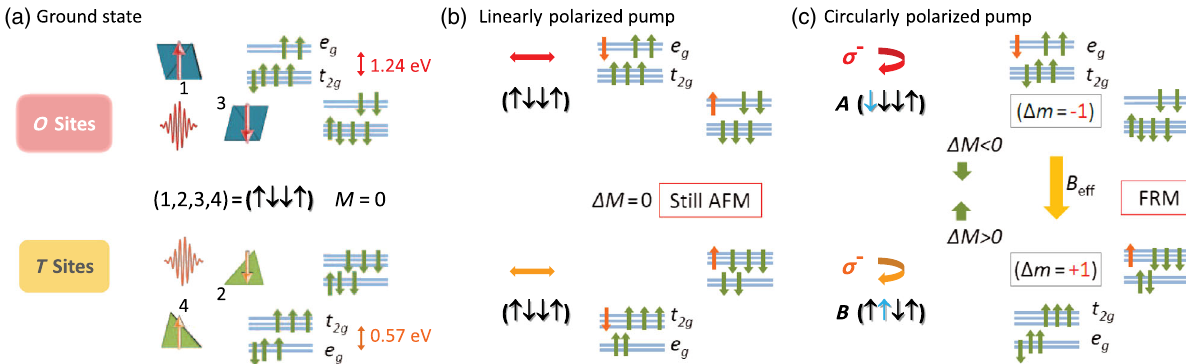
FIG. 4. Magnetization induced from the selective sublattice excitation. The upper (lower) schematics are displayed for O sites ( T sites). (a) Ground-state energy levels for O sites ( T sites) on sublattices 1 and 3 (2 and 4). The d 6 electrons are displayed with the split energies indicated by the double arrows. The energy separation is derived from measurements of Fig. 3, being consistent with the 10 Dq of the cubic field [20,21]. (b) The excited state created from linearly polarized light. The excited spin moments (orange arrows) preserve the total magnetic moments on both O and T sites, i.e., Δ M ¼ 0 . (c) The excited state created from circularly polarized photons σ − shown here. The transition involves the spin selection rule, i.e., Δ m ¼ (cid:2) 1 , with the flipped moment (orange arrows) frustrating the zero magnetization, i.e., Δ M ≠ 0 . See text for further detailed discussion. Here, the two transitions demonstrate the mechanism for a magnetic basis in Fig. 1 to create the configurations A and B from the sublattice spin moments ( ↑↓↓↑ ) of M ¼ 0